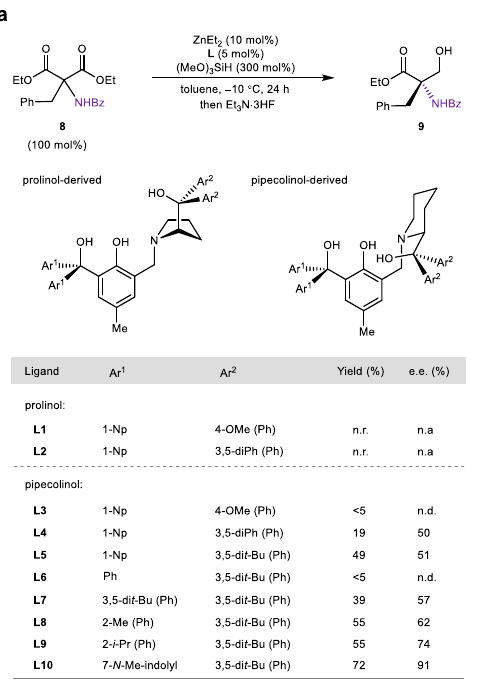
Fig.2|Optimizationofreductivedesymmetrizationofamino-andoxymalonic esters. a Optimization of ligand scaffold. Unless noted otherwise, the desymme- trization was run using 8 (0.1mmol), (MeO) 3 SiH (0.3mmol), tetradentate ligand (5mol%), and ZnEt 2 (10mol%) in toluene at − 10°C for 24h. The yields were determined using crude NMR spectra after work-up and e.e. values by chiral HPLC analysisofisolatedproduct.Bzbenzoyl,e.e.enantiomericexcess,n.r.noreduction, n.a. not available, n.d. not determined due to low yield. b Examination of six representative amino- and oxyamlonic esters. The absolute con fi guration of 9 was